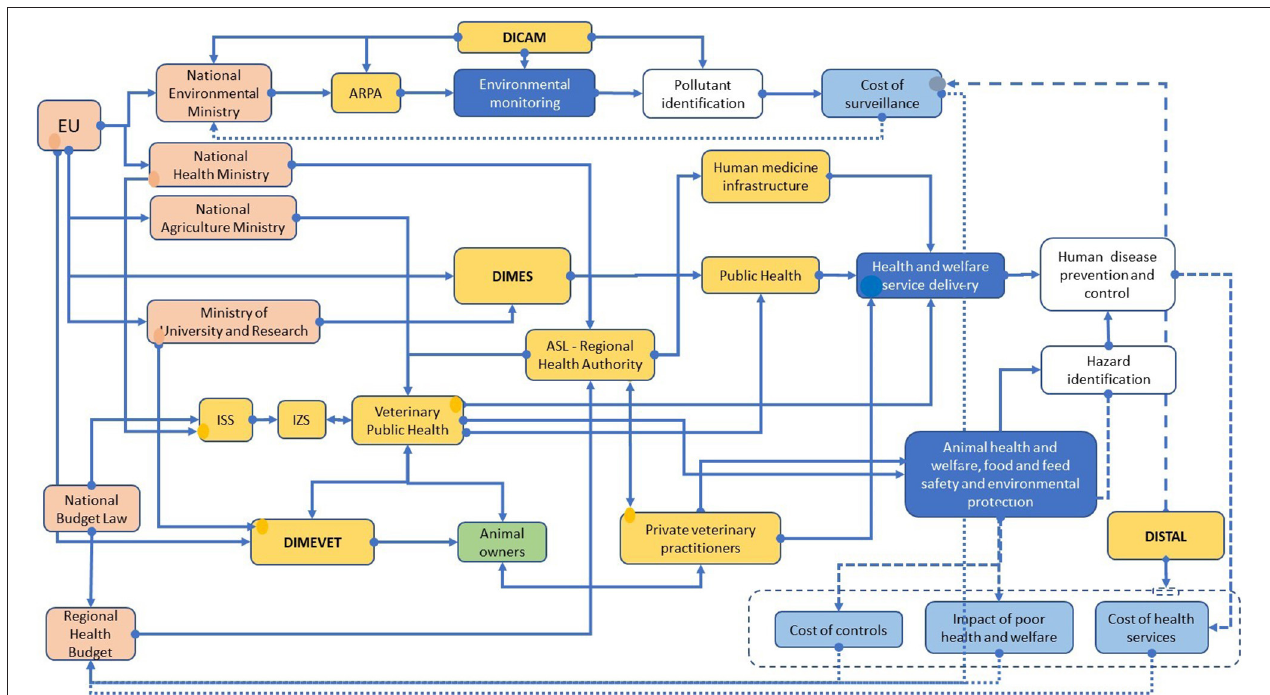
FIGURE 1 | The system diagram of the UNIBO